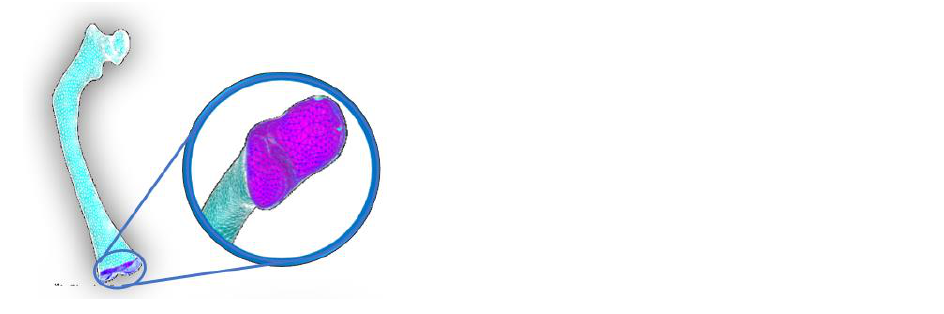
Figure 10. Border condition on the femur distal epiphysis, restricting all degrees of freedom. The Pauwels distributed load model was used to perform a femur analysis in the frontal plane, as a hip stabilization system in the monopodial support, a more critical con- dition in the gait cycle. The force exerted by the abductor’s muscles in this phase will be four times the infant’s weight. Considering a child with an OI weight of around 11 kg, a force equivalent of 431.64 N is obtained. This force was applied to the upper part of the femur head, as shown in Figure 11 (magenta zone) [43].